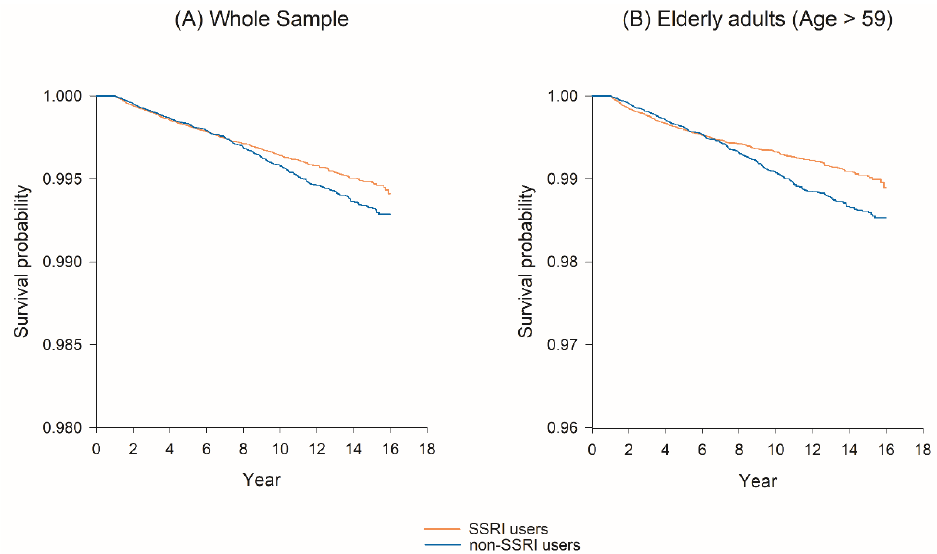
Figure 1. Survival probability of bladder cancer between SSRI and non-SSRI user groups.